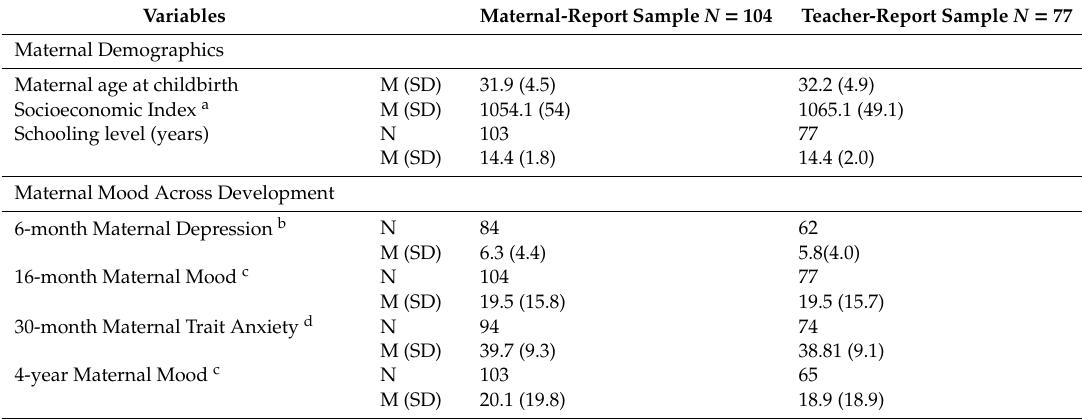
Table 1. Cohort descriptive statistics for study demographics, predictor, and outcome